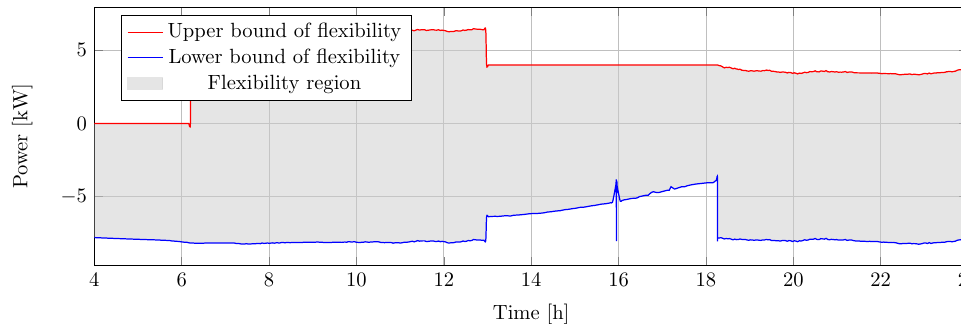
Figure 12. Available upward and downward flexibility for the summer sunny day scenario.